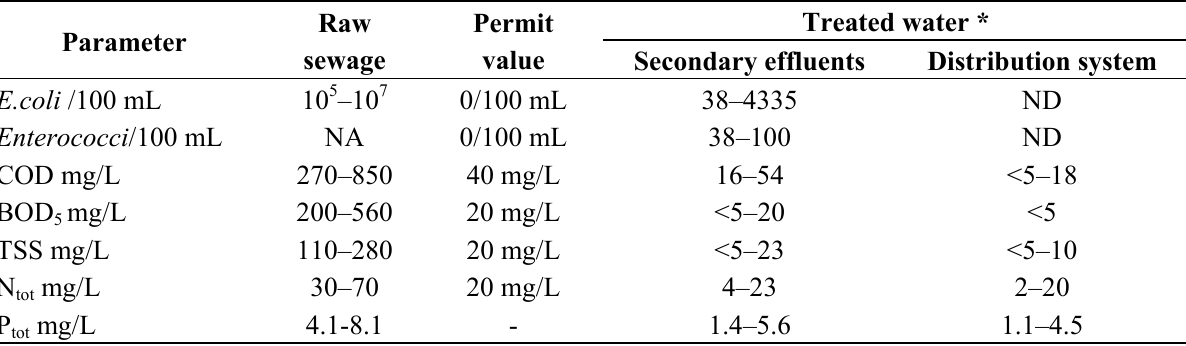
Table 1. Routine water quality control of the wastewater treatment and recycling facility of Povai for the year 2009.